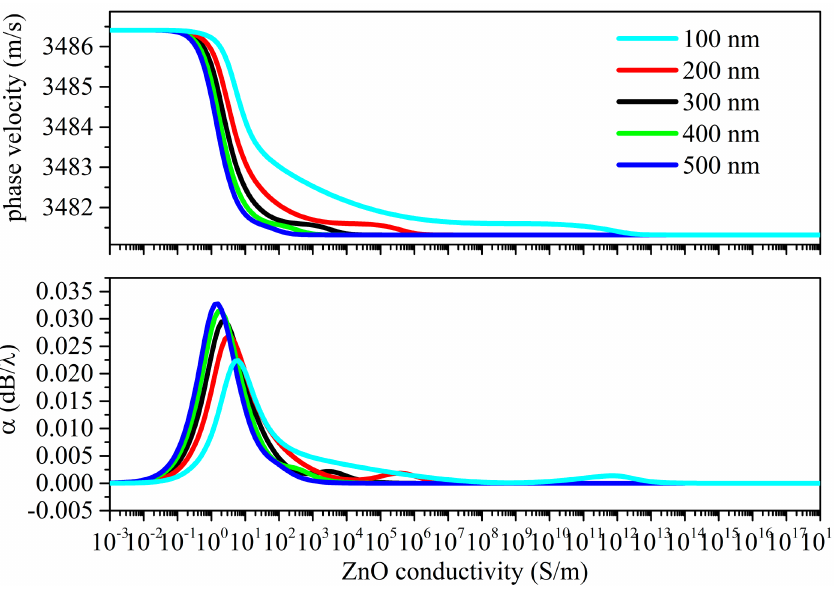
Figure 11. Sezawa wave phase velocity and propagation loss vs. conductivity curves under bottom illumination; the penetration depth is the running parameter.